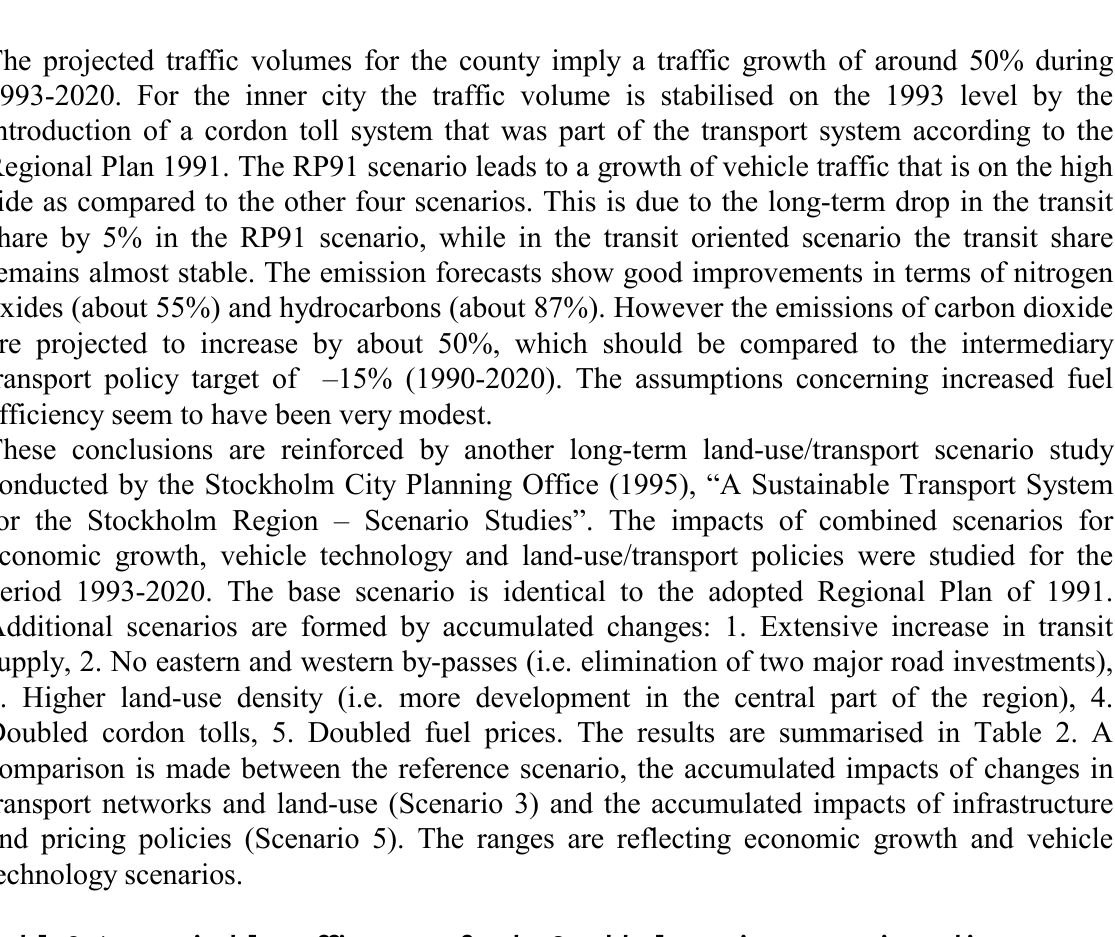
Table 2. A sustainable traffic system for the Stockholm region: scenario studies